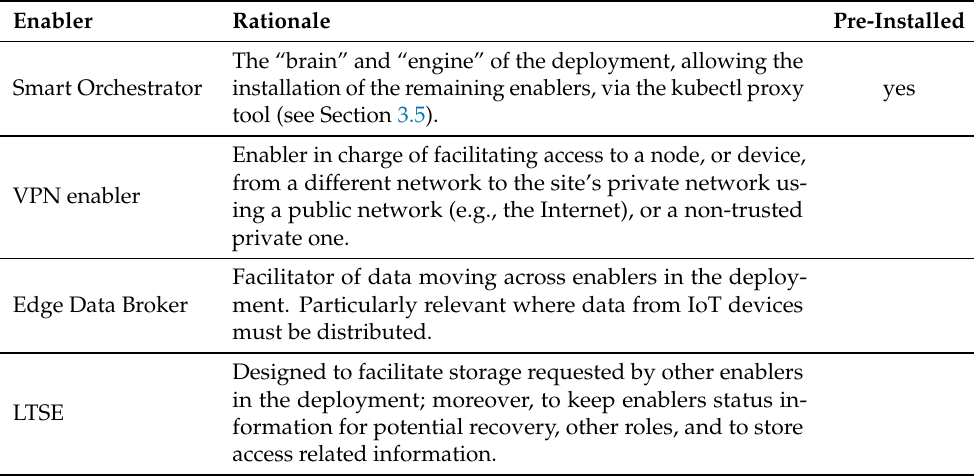
Table 1. ASSIST-IoT essential enablers